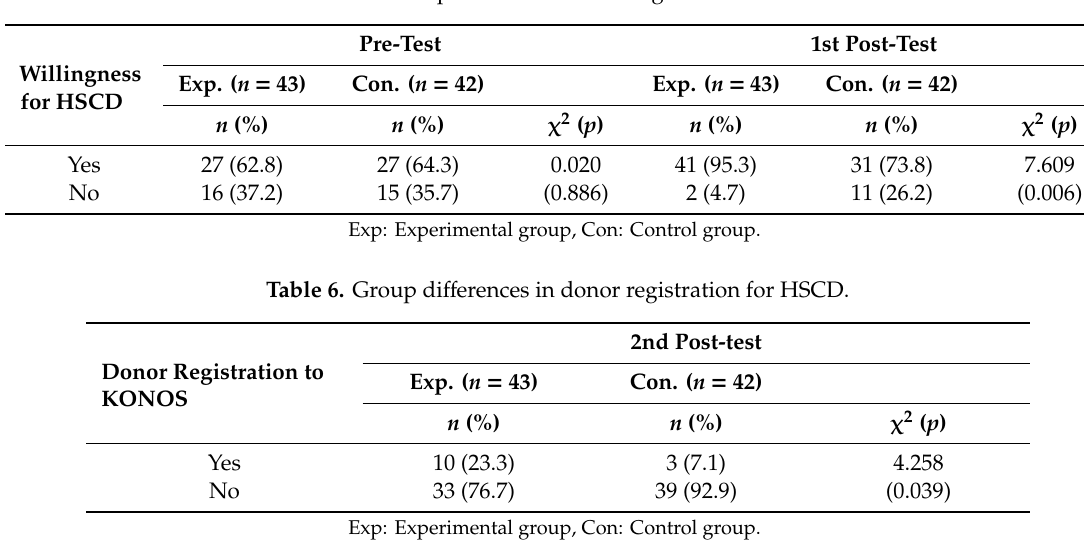
Table 5. Group di ff erences in willingness for HSCD.